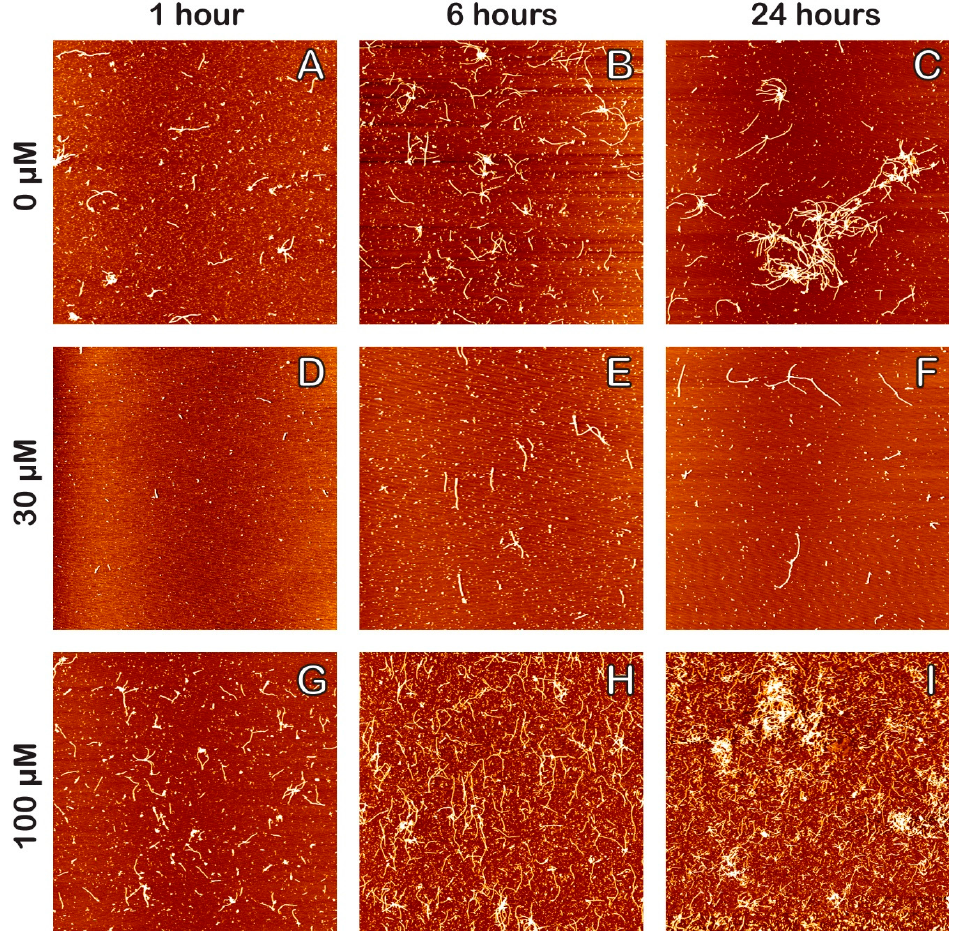
Figure 2. Atomic force microscopy images of A β 1–42 fibril formation with varying concentrations of DHA at different incubation times. A β 1–42 with 0 μ M DHA ( A , B , C ), 30 μ M DHA ( D , E , F ), and 100 μ M DHA ( G , H , I ) were incubated at 1, 6, and 24 h, respectively (images from left to right). To prepare the samples, 50 μ L aliquots of each solution were deposited onto freshly cleaved mica for 5 min, washed with Milli-Q nanopure water, and dried with nitrogen gas after their respective incubation times. The concentration of A β 1–42 in each of the samples is 110 μ M and the dimensions of each image are 10 × 10 μ m.